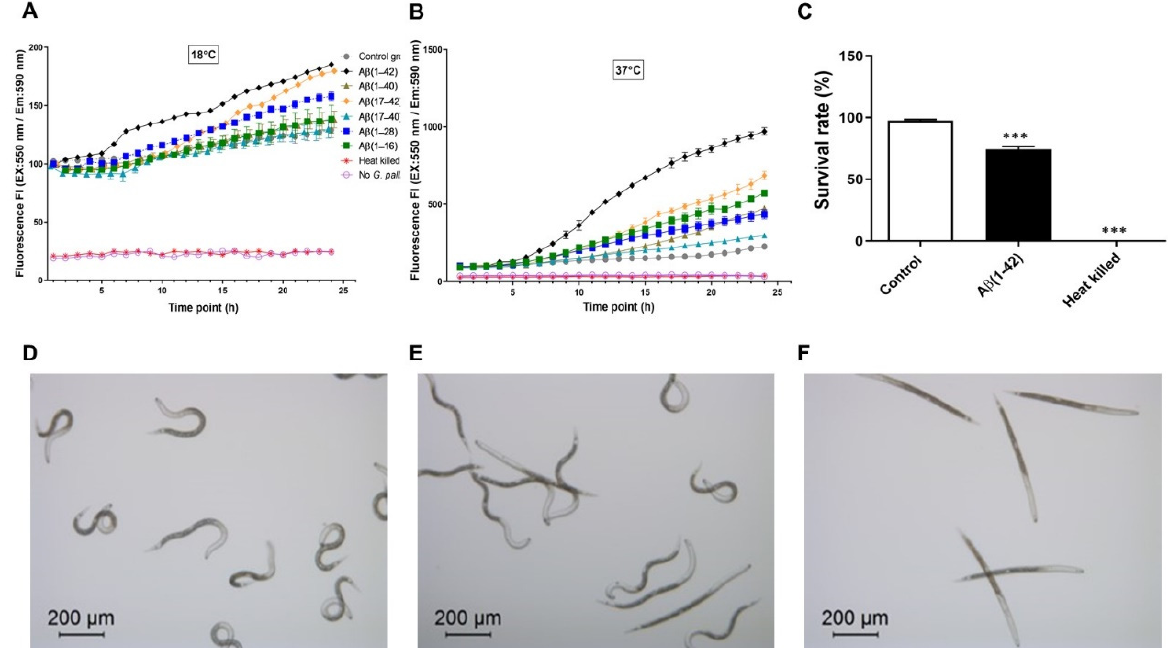
Figure 3. Changes in mitochondrial reductase activity in G. pallida in response to amyloid- β (A β ) peptide fragments. G. pallida were incubated with Alamar Blue either at a temperature of ( A ) 18 °C or ( B ) 37 °C, and the relevant A β fragment with fluorescence (Ex: 550 nm, Em: 590 nm) was measured every 30 min for 24 h (FLUOstar Omega microplate reader). A β (1–42) increased reductase activity by the greatest extent. Representative light microscopy images of G. pallida second-stage juveniles (J2s) following 24 h exposure to amyloid- β A β (1–42); ( C ) shows percent survival rate using counting by visual observation; ( D ) shows untreated worms (control) with characteristic ‘body bends’; ( E ) shows the A β (1–42)-treated group with mixed ‘body bends’ and ‘poker straight’ shape characteristics; ( F ) shows heat-killed worms with characteristic ‘poker straight’ shape. The data are mean ± SEM ( n = 3) with approximately 100 G. pallida organisms per observation. *** p < 0.001, compared with control.